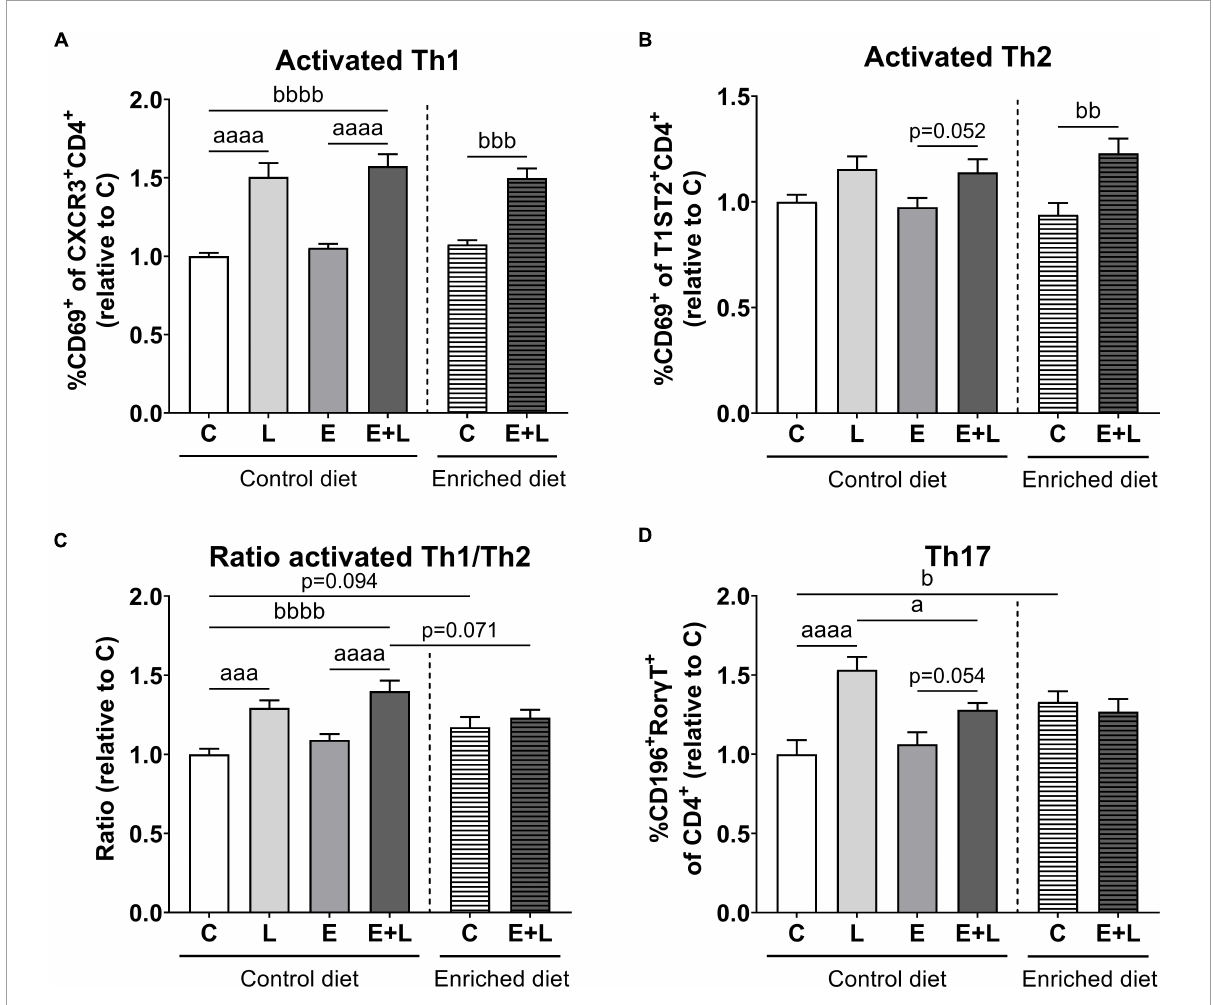
FIGURE6 Flow cytometric analysis of T cell populations in the spleen at the end of the study. Relative ratios as opposed to controls of activated Th1 (A) and Th2 (B) cell percentages, ratios of activated Th1/Th2 cells (C) and Th17 cell percentages (D) are presented. Data are expressed as mean ± SEM. a p < 0.05; aaa p < 0.001; aaaa p < 0.0001 (first analysis for elastase and/or LPS effects). b p < 0.05; bb p < 0.01; bbb p < 0.001; bbbb p < 0.0001 (second analysis for diet and/or E + L effects). C = control (control diet: n = 14; enriched diet: n = 13); L = LPS ( n = 13); E = elastase ( n = 16); E + L = elastase plus LPS (control diet: n = 18; enriched diet: n =